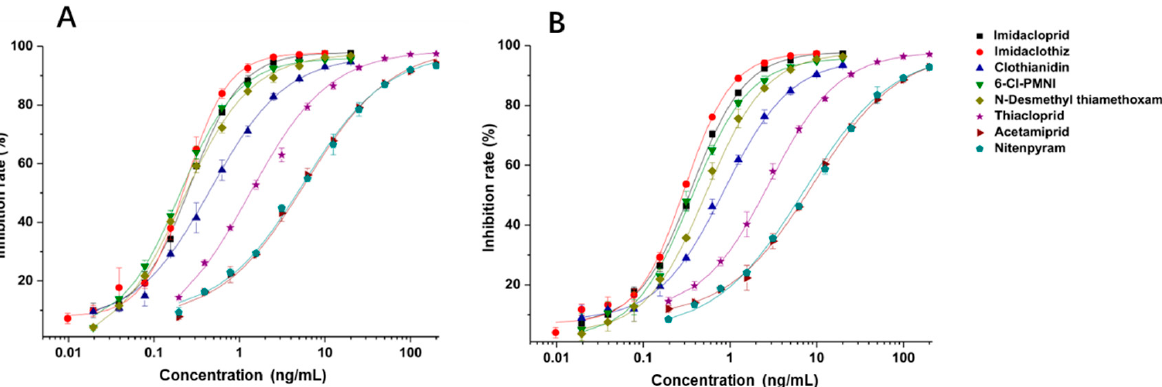
Figure 4. Standard curves for the detection of neonicotinoid pesticides and metabolites by icELISAs based on 6F11-mAb ( A ) and 6F11-rAb ( B ). The error bars represent the standard deviations of the data points ( n = 3). Table 2. Selectivity of 6F11-mAb and 6F11-rAb toward neonicotinoid pesticides and metabolites. Neonicotinoids